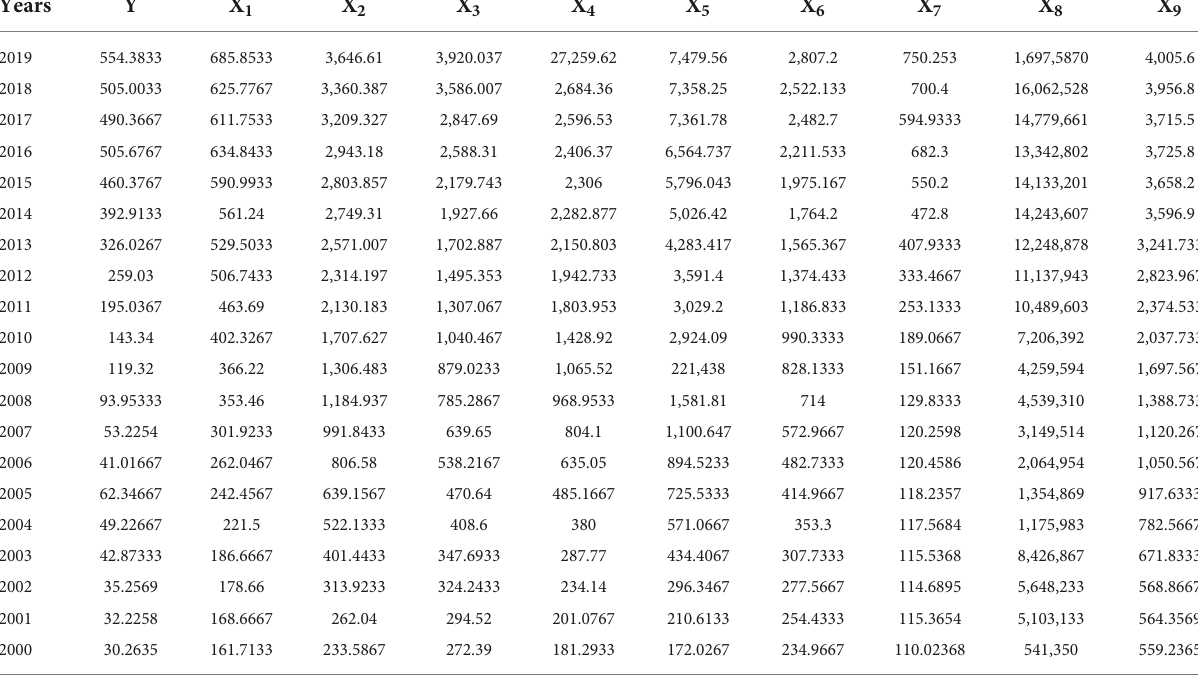
TABLE 1 Tax revenue model